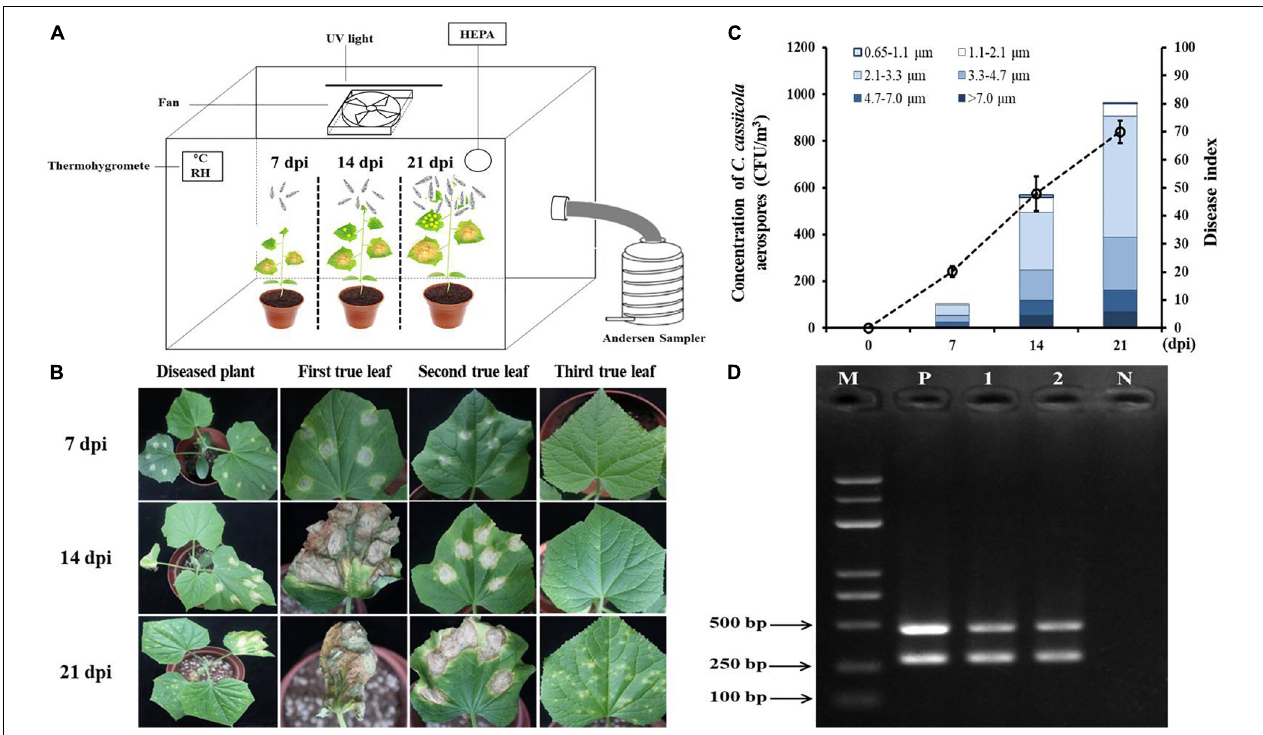
FIGURE 5 | Airborne dispersal of the hygromycin-resistant (HygR) Corynespora cassiicola strain by artificially infested cucumber plants in the exposure chamber. (A) Experimental scheme of airborne dispersal analysis. The first and second true leaves of cucumber seedlings were inoculated at six points using 1 × 10 5 spores/mL C. cassiicola :HygR spore suspension. C. cassiicola :HygR was released from inoculated leaves and transmitted to uninoculated leaves. Aerospores were collected at 0, 7, 14, and 21 dpi by an Andersen six-stage sampler. (B) Symptoms observed on artificially infested cucumber plants at 7, 14, and 21 dpi. (C) Population dynamics and size distribution of C. cassiicola :HygR at 7, 14, and 21 dpi. Particle size was determined by the Andersen sampler based on their inertia-related aerodynamic diameter. Error bars of the disease index represent the standard deviations of three biological replicates. (D) Detection of the ga4 and HygR genes in diseased leaves sampled from C. cassiicola :HygR-infected inoculated and uninoculated cucumber leaves by PCR. Lane M, marker; Lane 1, genomic DNA from leaves of C. cassiicola :HygR-infected inoculated cucumber leaves; Lane 2, genomic DNA from uninoculated cucumber leaves; Lane N, genomic DNA from leaves of control healthy cucumber plants; Lane P, positive